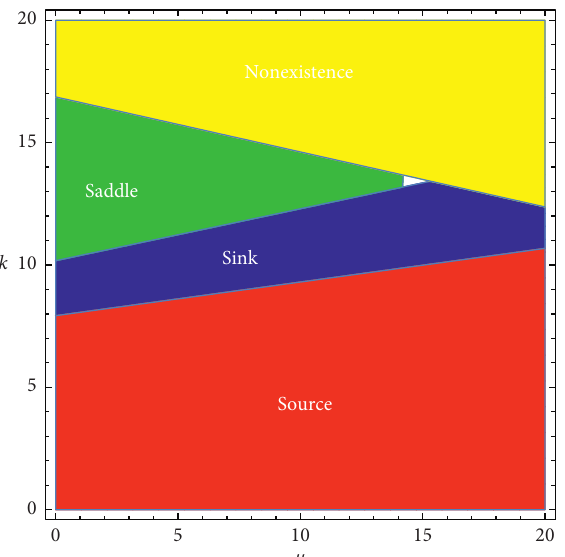
Figure 3: Dynamical classification of interior equilibrium of system (4) in μ k